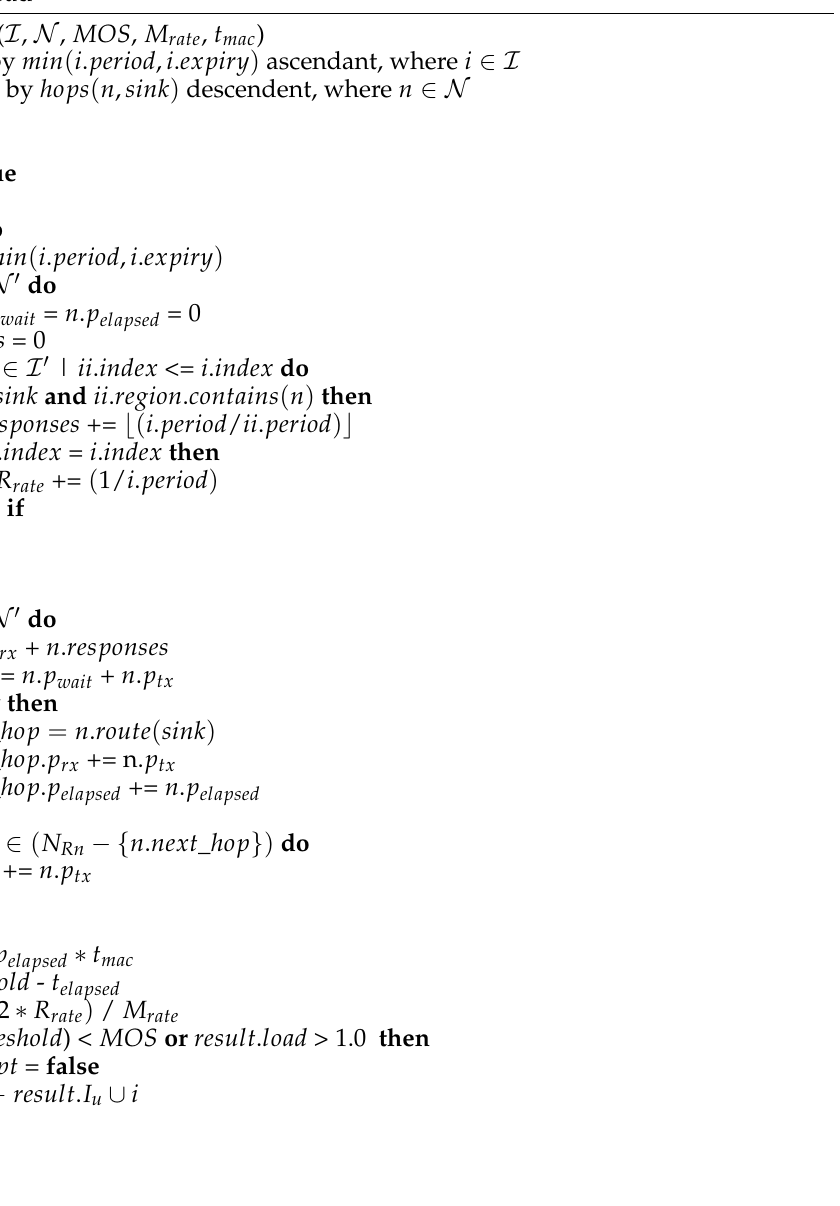
Algorithm 1 Network